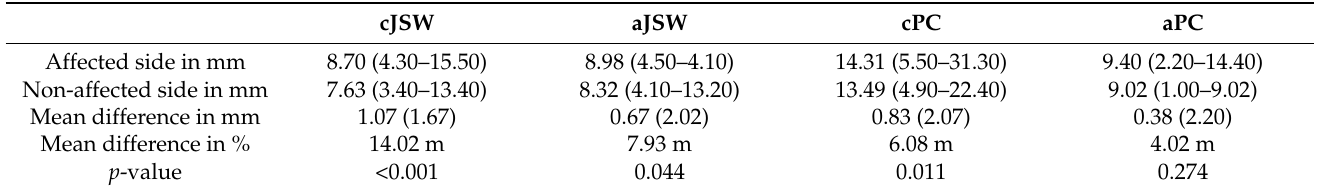
Table 2. Joint space width and position of the medial clavicle in affected and non-affected side.